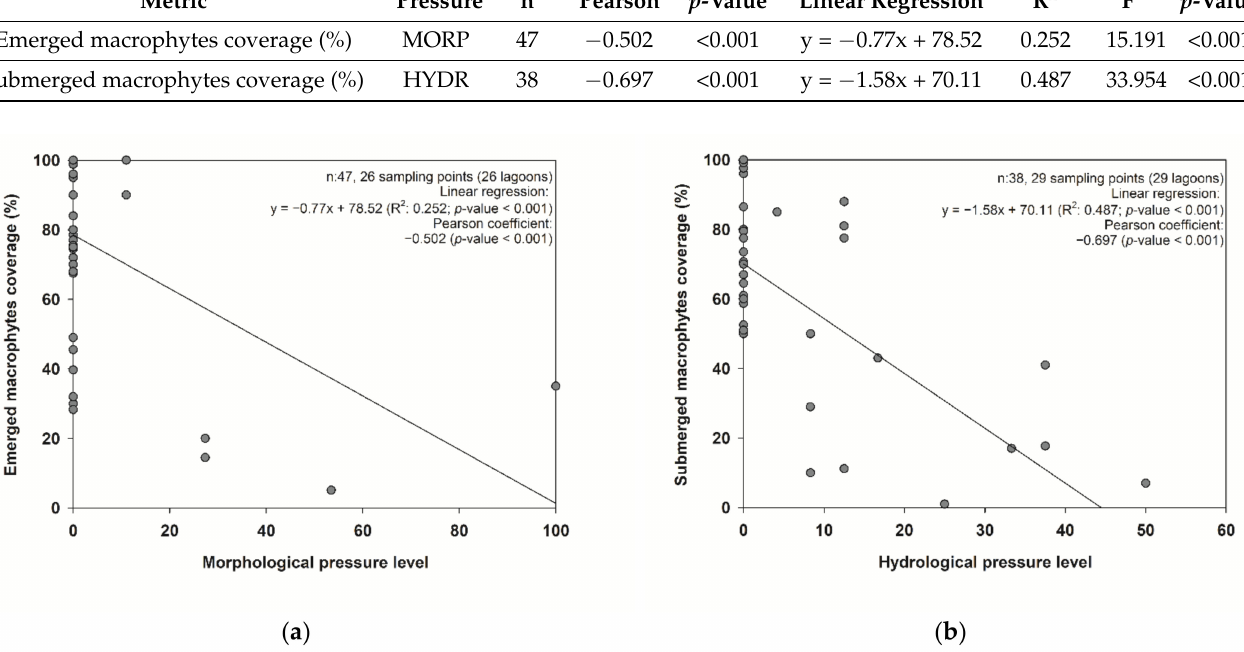
Figure 8. Relationship between ( a ) morphological pressure level with helophyte coverage and ( b ) hydrological pressure level with hydrophyte coverage. Pearson coefficient (with the significance of the correlation), as well as linear regression (with the R 2 and significance of the regression model) are